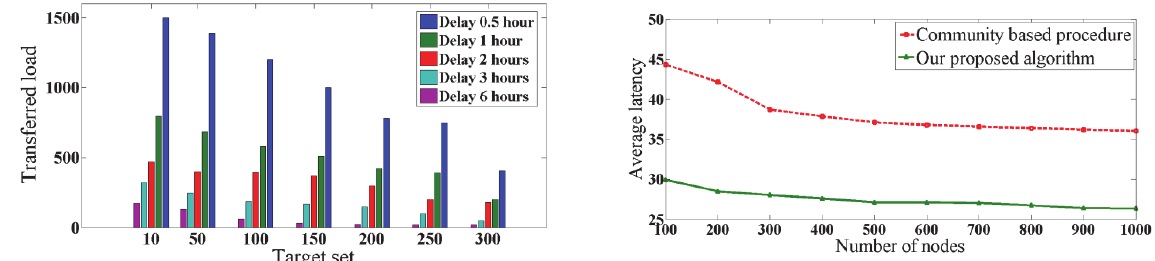
Fig. 5. Target set with transferred load Fig. 6. Latency changes with different target set